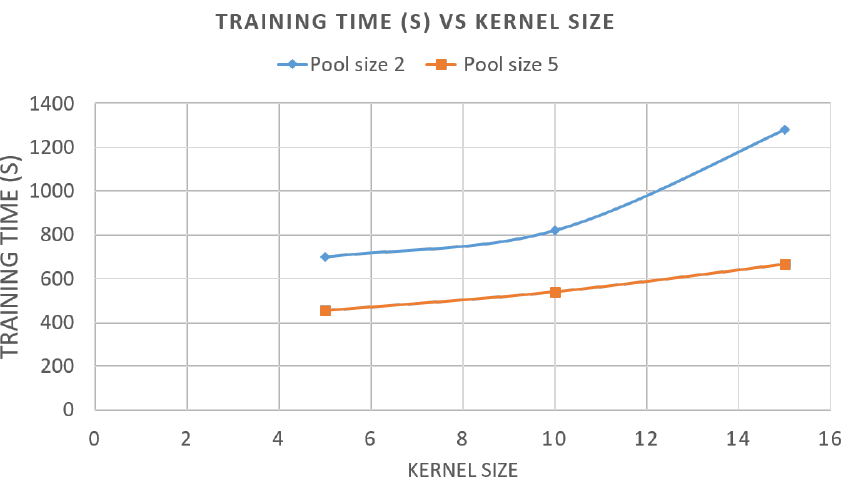
Figure 14. Comparison between the total training time and the kernel size for the CNN when fixing the pool size to 2 (blue) and 5